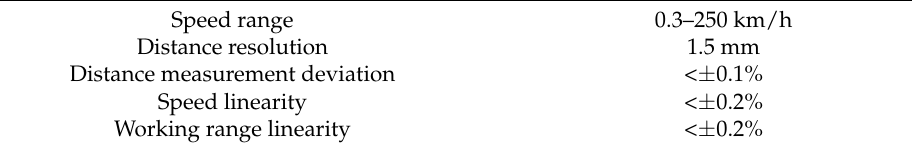
Table 2. Datron L-350 Aqua